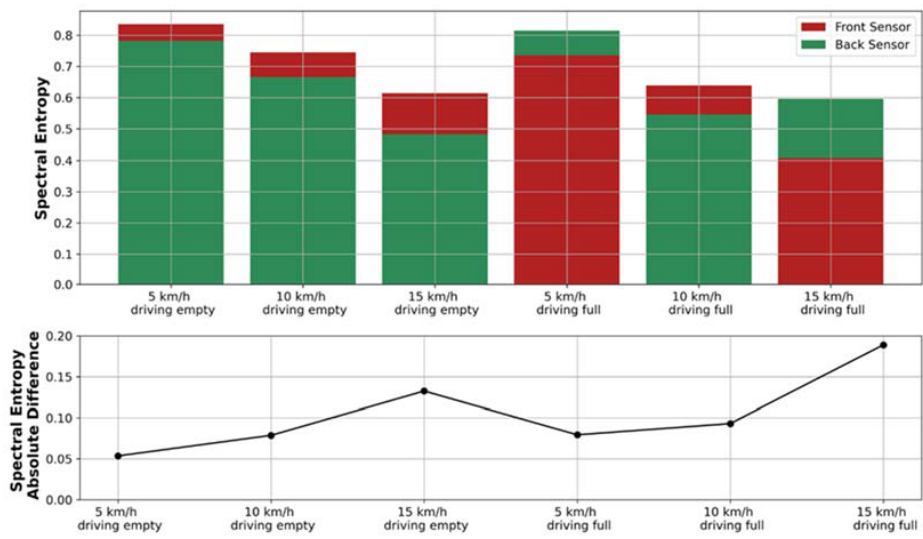
Figure 6. Entropy analysis during experimental driving over bumps. The spectral entropy of the Z-axis accelerometer for the front and back of the machine and the absolute difference between the entropy measured at the front and the